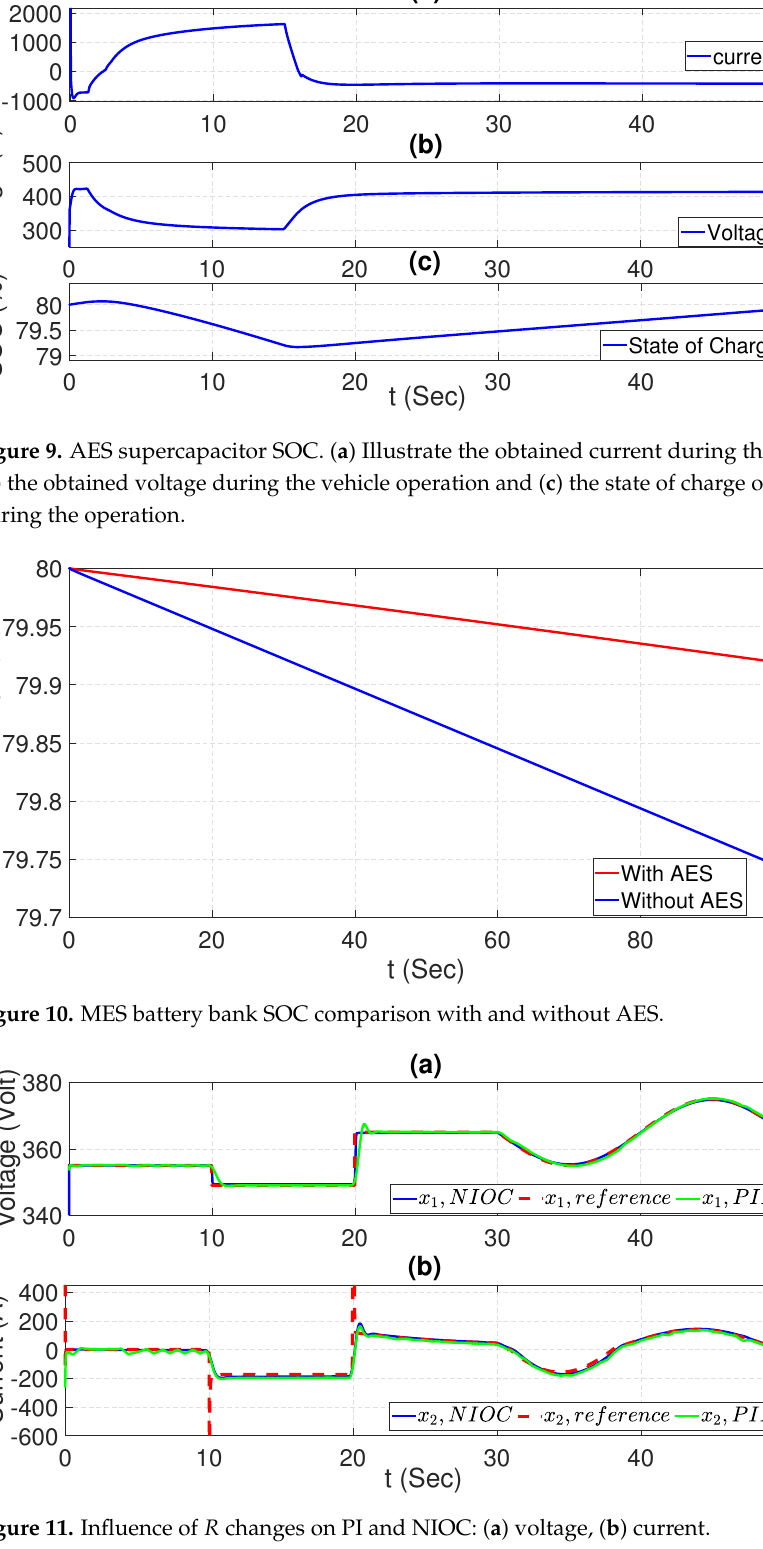
Figure 11. Influence of R changes on PI and NIOC: ( a ) voltage, ( b )